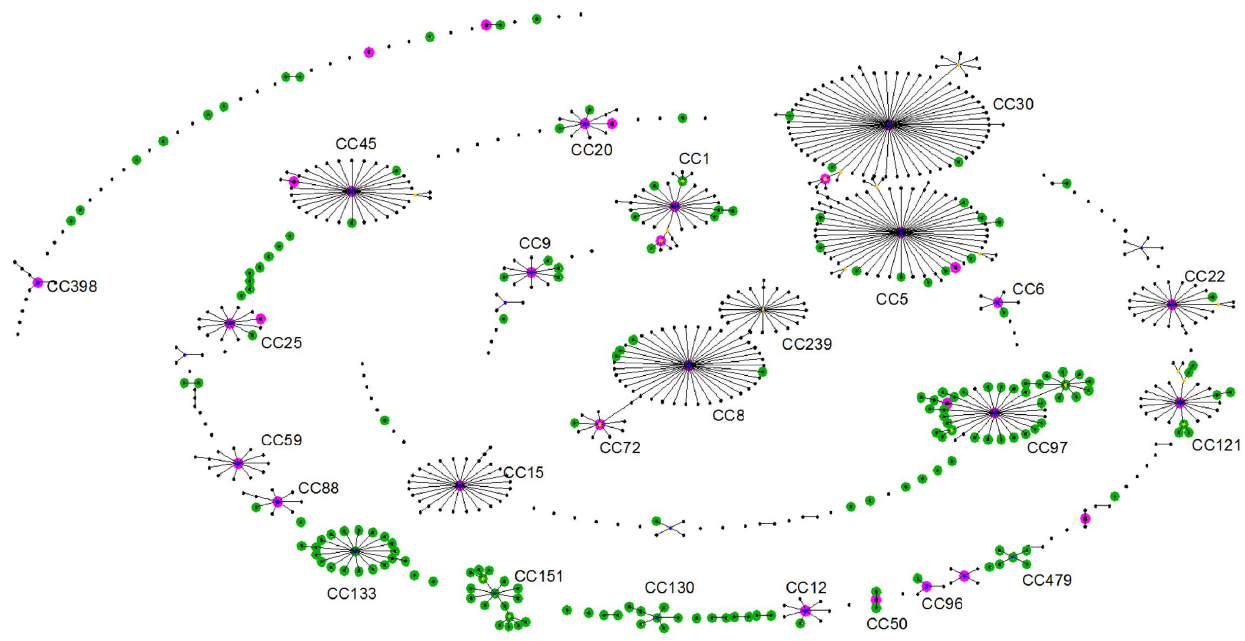
Figure 2. A Comparative eBURST plot of 696 STs from human and animal hosts. Comparative eBURST of 696 STs. Genotypes from the human habitat are shown in black, genotypes from the animal habitat are shown in green. Genotypes found in both habitats are highlighted in pink. Nodes with yellow centers indicate genotypes defined by eBURST as sub-founders within a larger clonal complex.